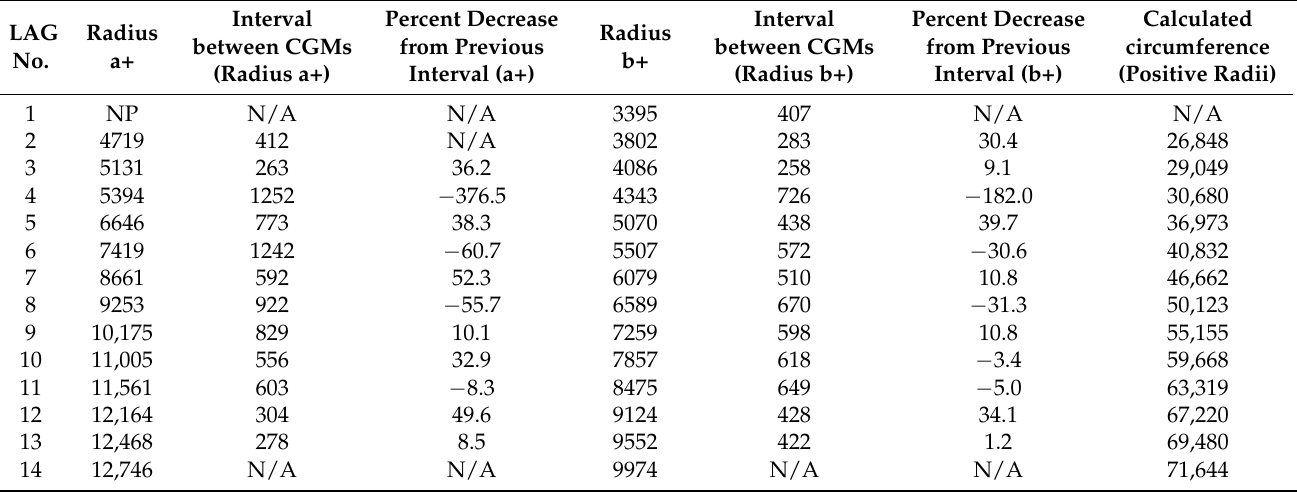
Table 2. Distance (to the nearest micron) from the centroid to each preserved LAG in the upper right quadrant of the right femur of NJSM 23368 (slide 1, scan 1 CPL), in centrifugal order. CGM = Cyclical Growth